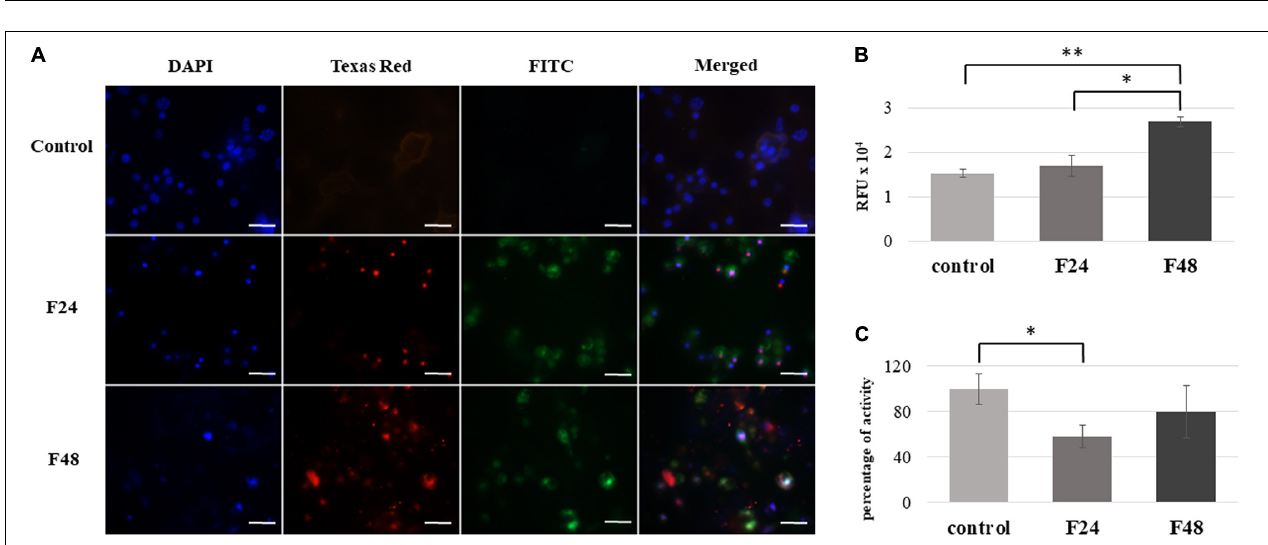
FIGURE 4 | Effect of C. coronatus infection on caspase activity in G. mellonella hemocytes. The multicaspase analysis was performed using the Carboxyfluorescein MultiCaspase Activity Kit (Enzo Life Science): (A) Fluorescence microscopy detection. Texas Red filter, propidium iodide (PI); FITC filter, carboxyfluorescein (FAM); DAPI filter, cell nuclei; scale bar 25 µ m. (B) Quantitative analysis using fluorometry (C) Caspase-1 activity measurements were performed using the Caspase-1 colorimetric assay kit (Enzo Life Science). The results are presented as a percentage of activity in relation to controls, assumed as 100%. Data are presented as means and standard deviations; RFU, Relative Fluorescence Unit. ∗ p ≤ 0.005, ∗∗ p < 0.0001 (Student’s t -test, p ≤ 0.05). Control (negative control), non-infected, healthy larvae; F24, larvae sampled immediately after 24-h exposure to C. coronatus sporulating colonies; F48, larvae sampled 24 h after 24-h exposure.